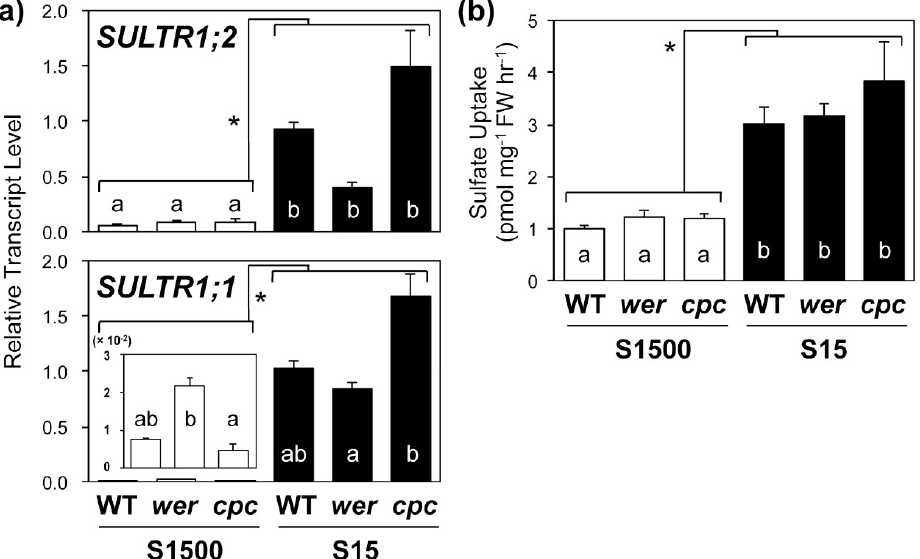
Figure 4. Transcript levels of SULTR1;1 and SULTR1;2, and sulfate uptake activity in wild-type (WT), werwolf ( wer ), and caprice ( cpc ) mutants grown under S1500 and S15 conditions. ( a ) Relative transcript levels of SULTR1;1 and SULTR1;2 in root tissues determined using quantitative reverse transcription-polymerase chain reaction (qRT-PCR). ( b ) Sulfate uptake activity of plants. Absolute values of [ 35 S] sulfate uptake rates are presented. Plants were vertically grown for 10 d on S1500 (white bars) and S15 (black bars) agar media. Values and error bars indicate means ± SEM [n = 3 in ( a ), n = 6 in ( b )]. Two-way analysis of variance (ANOVA) was used to detect the e ff ects of sulfur conditions, genotypes, and their interactions. Asterisks indicate significant di ff erences between S1500 and S15 conditions (two-way ANOVA; * P < 0.05). In ( a ), interactions between sulfur conditions and genotypes were detected and, so the Tukey–Kramer test was applied to all six experimental conditions. In ( b ), under the same condition. Di ff erent letters indicate significant di ff erences ( P <